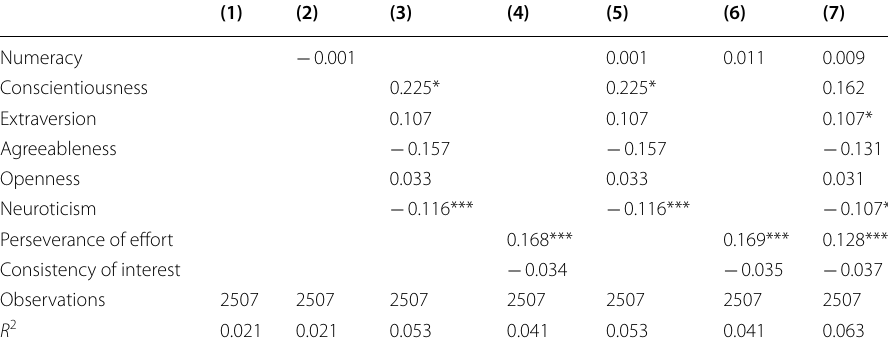
Table 5 Job satisfaction and cognitive and non-cognitive skills